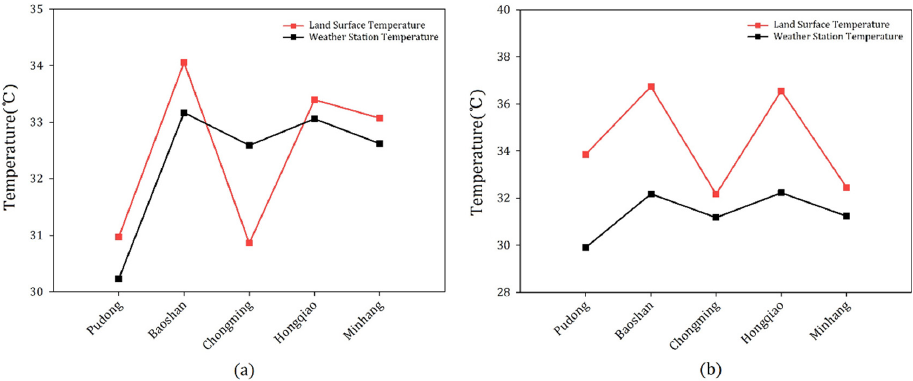
Figure A1. Comparison and verification of the air temperature and the LSTs in Shanghai on 3 August 2015 ( a ) and 16 August 2020 ( b ), respectively.